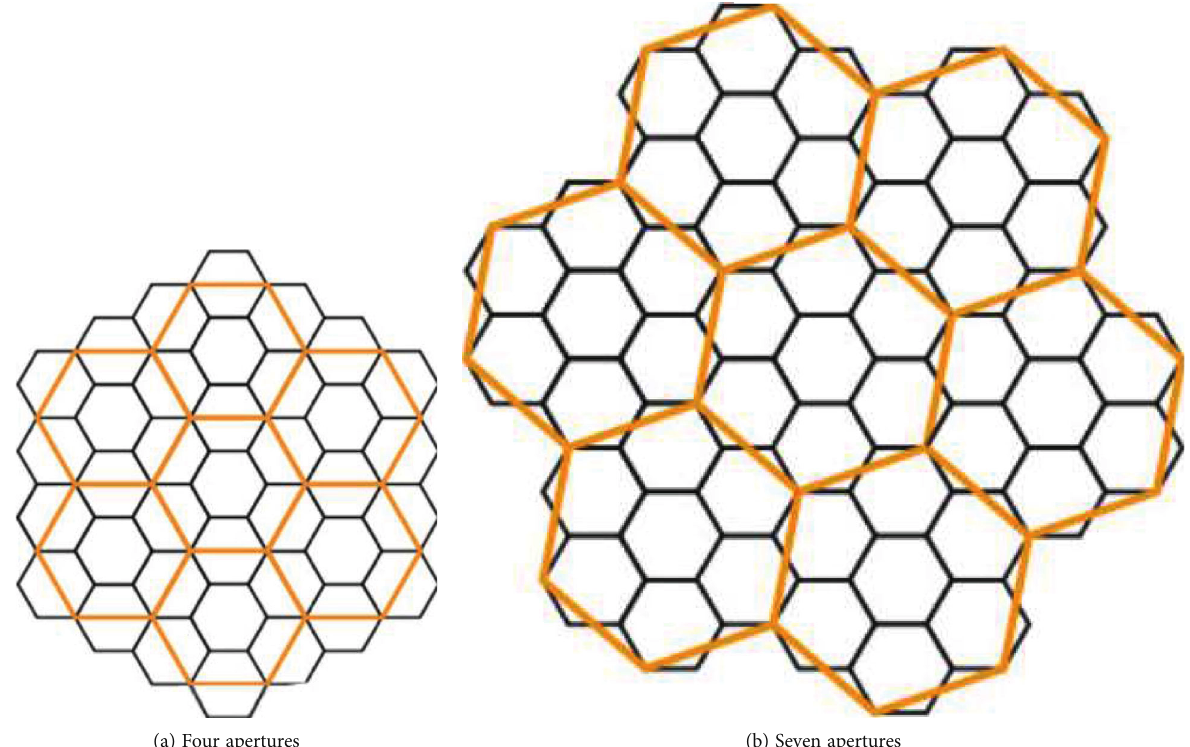
Figure 3: Schematic diagrams of four- and seven-aperture division. Table 3: Error settings of the inertial components. Inertial